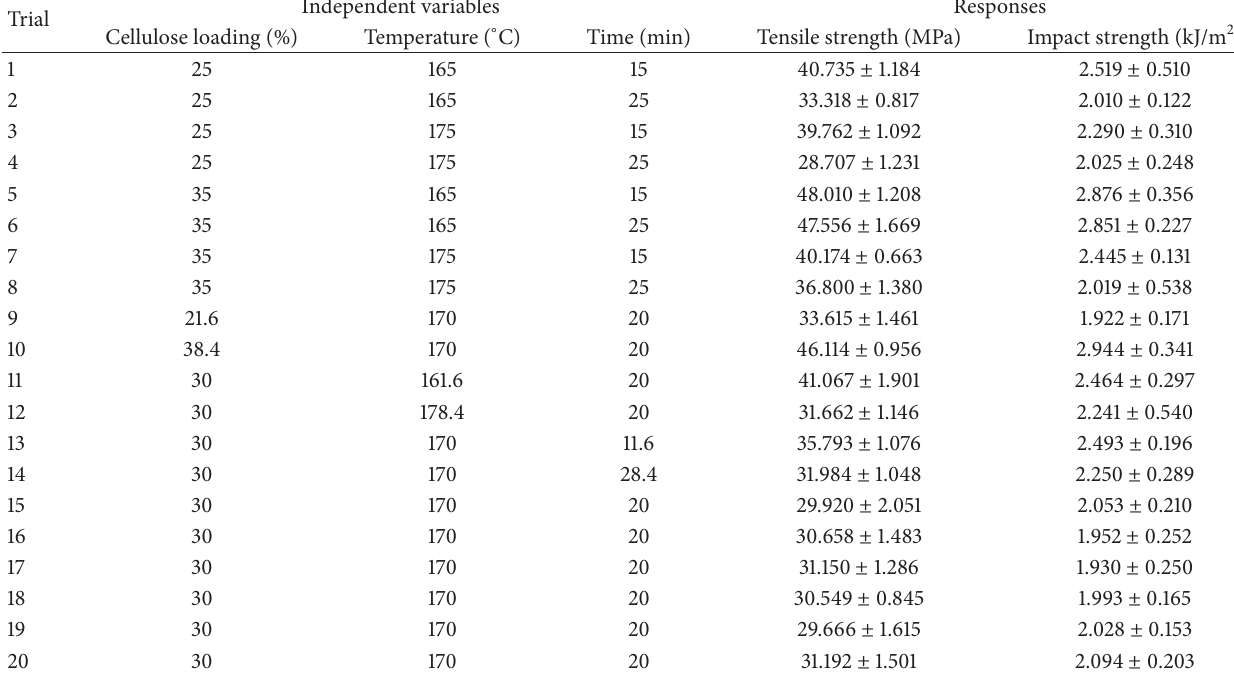
Table 3: The responses of the parameters used in central composite